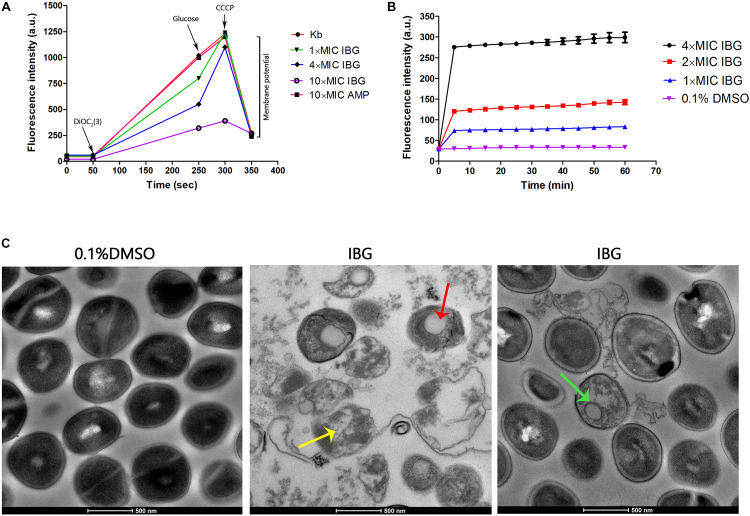
IBG exerts its antibacterial action on the cell membrane of S. aureus. (A) IBG dissipates the membrane potential of S. aureus ATCC 29213. P values were determined using a non-parametric one-way ANOVA. P values of (*≤0.05) (**P ≤ 0.01) are considered as significant. (B) Uptake of SYTOX Green by exponential-phase S. aureus ATCC 29213 cells treated with IBG. (C) Transmission electron micrographs of S. aureus cells in response to IBG. Scale bars, 500 nm. These arrows indicate damage to the cell membrane by IBG. Kb, S. aureus ATCC 29213 control cell treated with 0.1% DMSO.